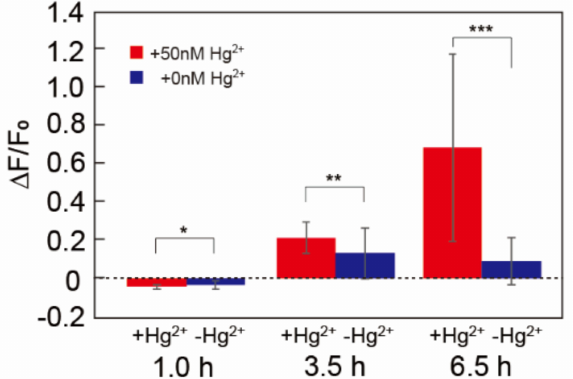
Figure 7. Detection of mercury ions in a water sample from the Kamo river. Average relative fluorescence intensities in the microchambers with river water containing 50 nM of Hg 2+ (+50 nM Hg 2+ , red bars) and non-treated river water (+0 nM Hg 2+ , blue bars) after 1.0, 3.5, and 6.5 h. The river water sample with 50 nM of Hg 2+ was prepared by dissolving HgCl 2 into the river water. The water samples were injected in the microfluidic device at 0 h. Error bars represent standard deviation ( n = 4). * p < 0.5, ** p < 0.5, *** p < 0.05 (Welch’s t -test) [25]. The freeze-drying condition